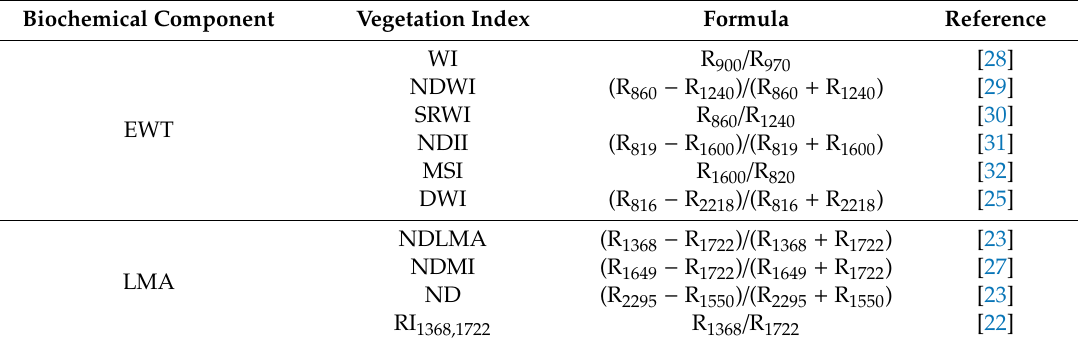
Table 2. Vegetation indices used for the estimation of leaf equivalent water thickness (EWT) and leaf mass per area